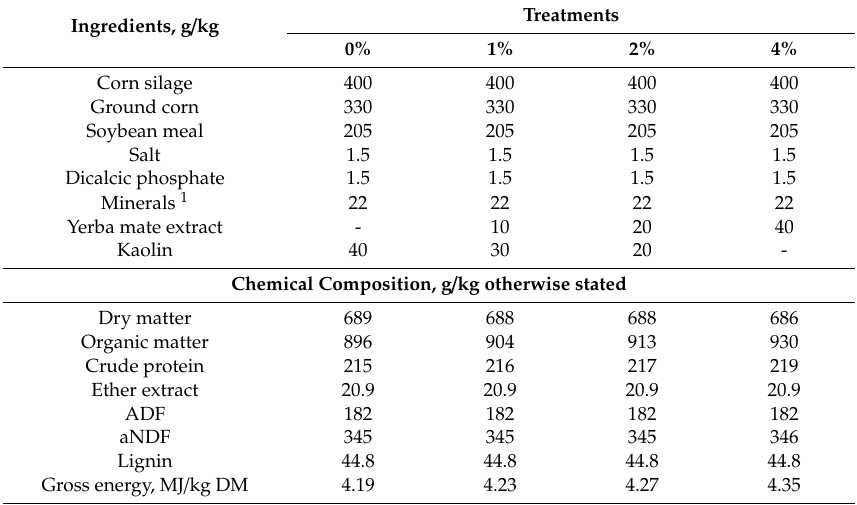
Table 1. Ingredient and chemical composition of experimental diets in a dry matter